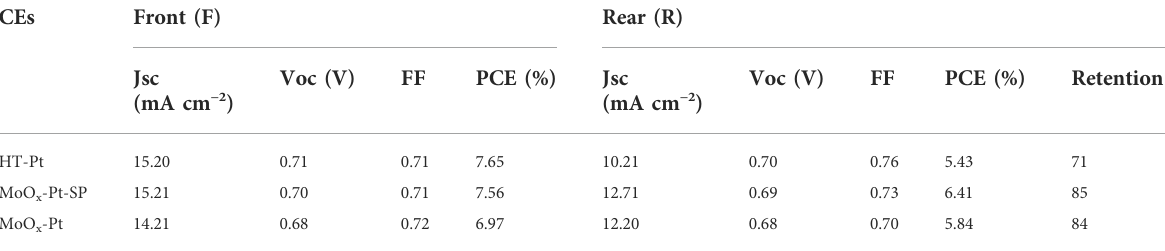
TABLE 3 Photovoltaic parameters of DSCs illuminated from the front (F) and rear (R) sides. CEs Front